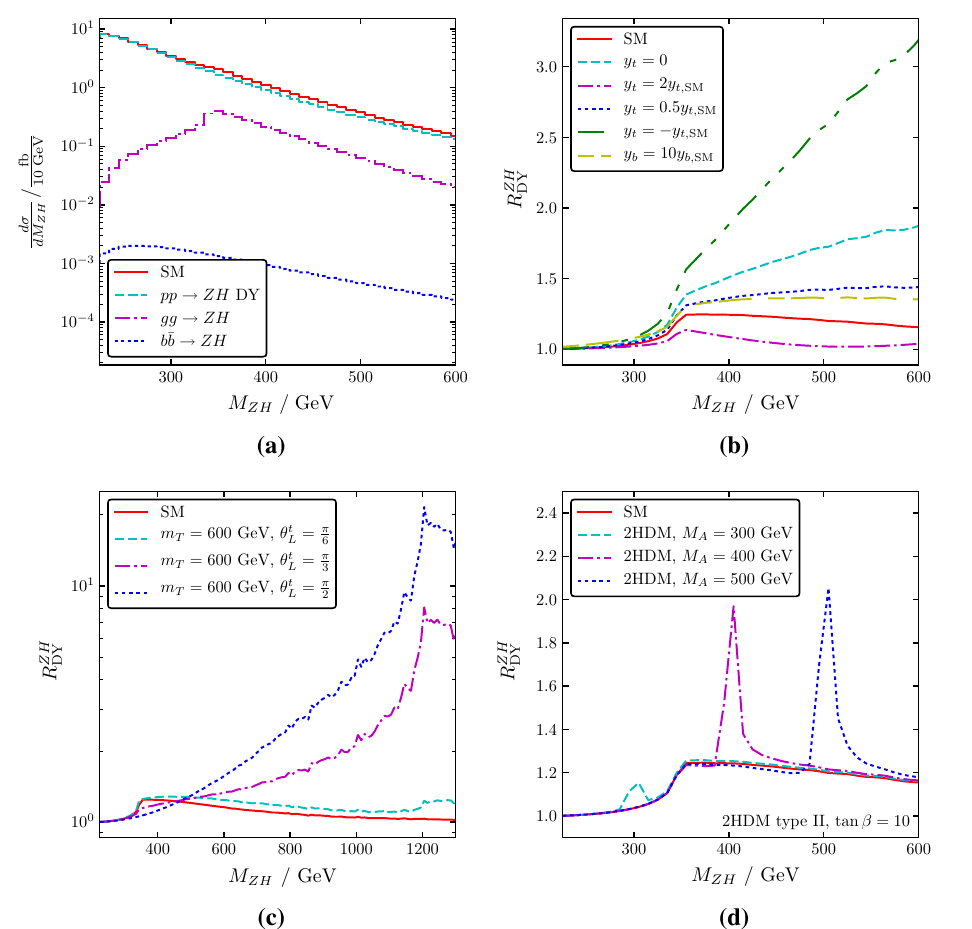
Fig. 3 a The ZH invariant mass spectrum in the SM: total cross sec- tion (solid red), DY component (dashed cyan), gg → ZH compo- nent (dash-dotted purple), b ¯ b → ZH component (dotted blue). b The ratio R ZH of the full ZH cross section to the DY component in the DY SM (solid red) and for modified values of the top- and bottom-quark Yukawa coupling, including various new-physics effects. c R ZH SM+VLQs of mass 600GeV, and various values of the VLQ mixing